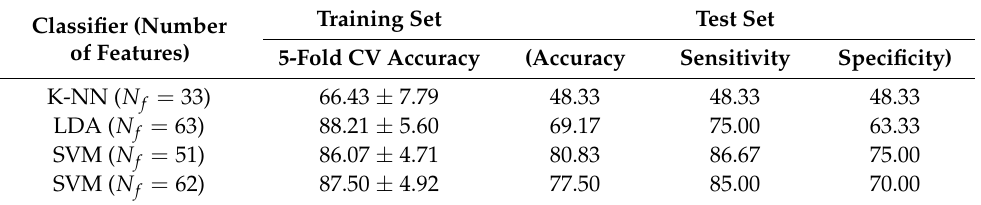
Table 6. Comparison of training and testing classification accuracy among different classifiers (in